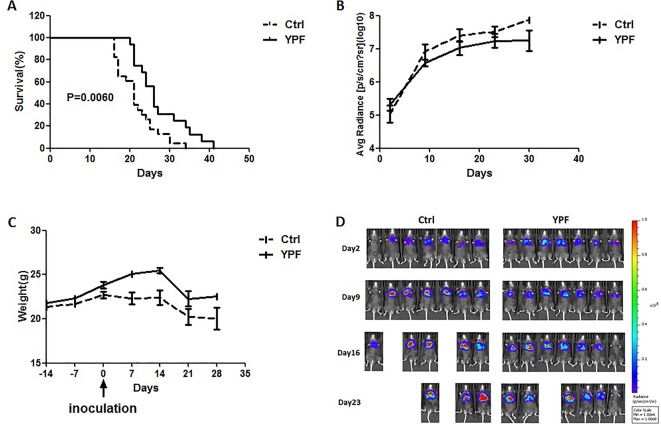
YPF prolonged the survival rate of orthotopic lung tumor-bearing mice, inhibited the growth of LLC tumor cells and reduced the decline of body weight. The LLC-Luc cells (5×105 cells/mouse) were orthotopic inoculated in the left lung of C57BL/6 mice. The mice were administered with normal saline or YPF at a daily dose of 117mg for each mouse for 14 consecutive days before inoculation. (A) Survival curves, P = 0.0060. (B) The average radiance of tumor at different time points. (C) The weight of mice at different time points. (D) The photos of mice bioluminescence imaging at different time points.